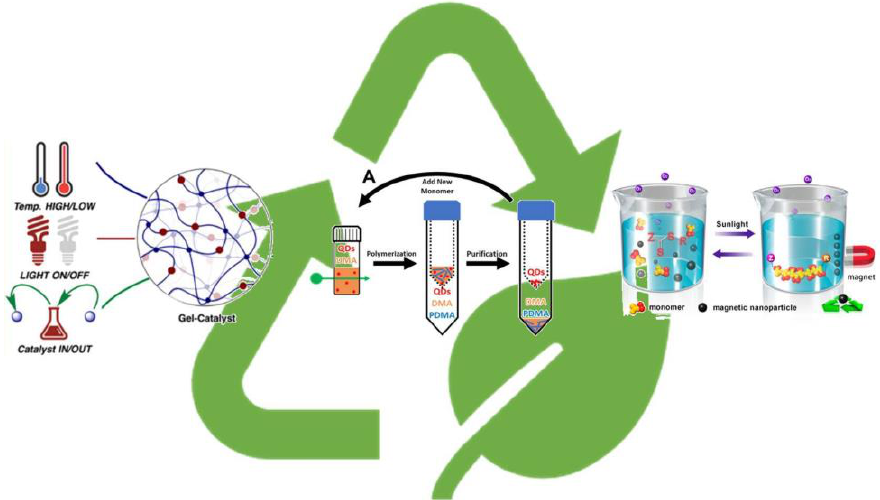
Figure 7. Recyclability of photoredox catalyst in PET-RAFT process. Adapted from refs. [57–59].